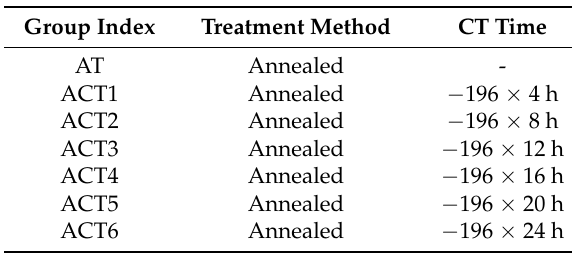
Figure 1. ( a ) QTF-1200X vacuum tube furnace; and ( b ) the annealed samples for punch shearing tests. Table 2. Treatment groups.